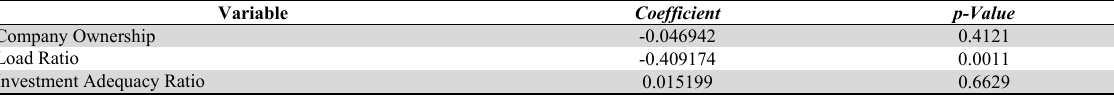
Results of the Tobit Model